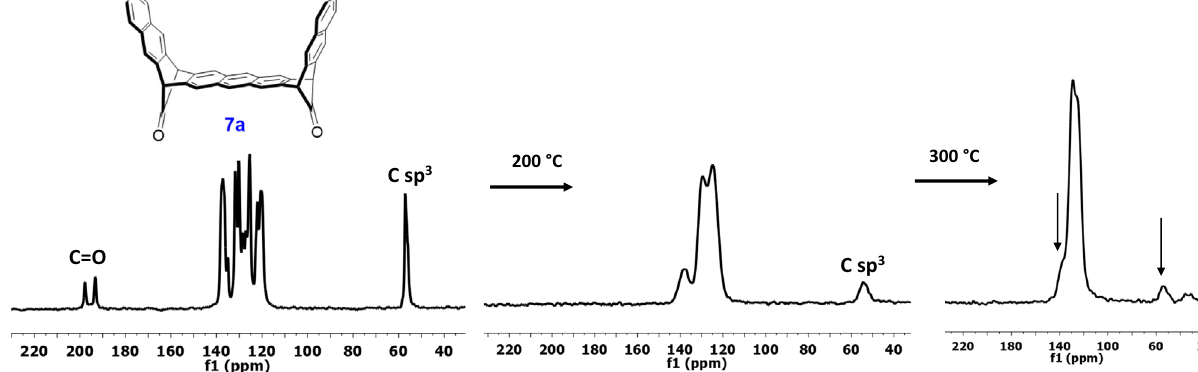
Fig. 7 Thermal decarbonylation of 7a. Evolution of the CPMAS 13 C NMR spectra of 7a (left) in function of